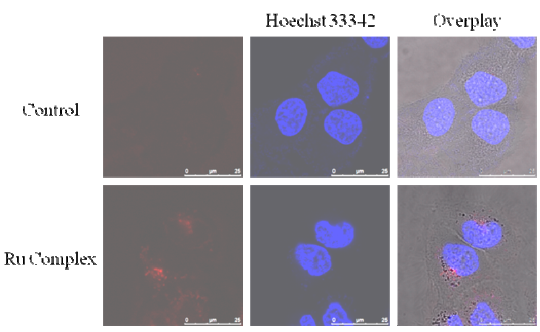
Figure 3. Confocal microscopy images of MCF-7 cells subjected to ligation with 5 , followed by staining with Hoechst 33342 (blue, nucleus-specific dye). The overlay indicates the colocalization of ruthenium complex 5 and the Hoechst 33342.